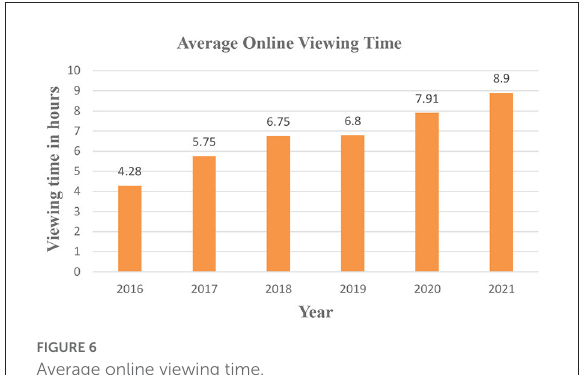
FIGURE6 Average online viewing time.